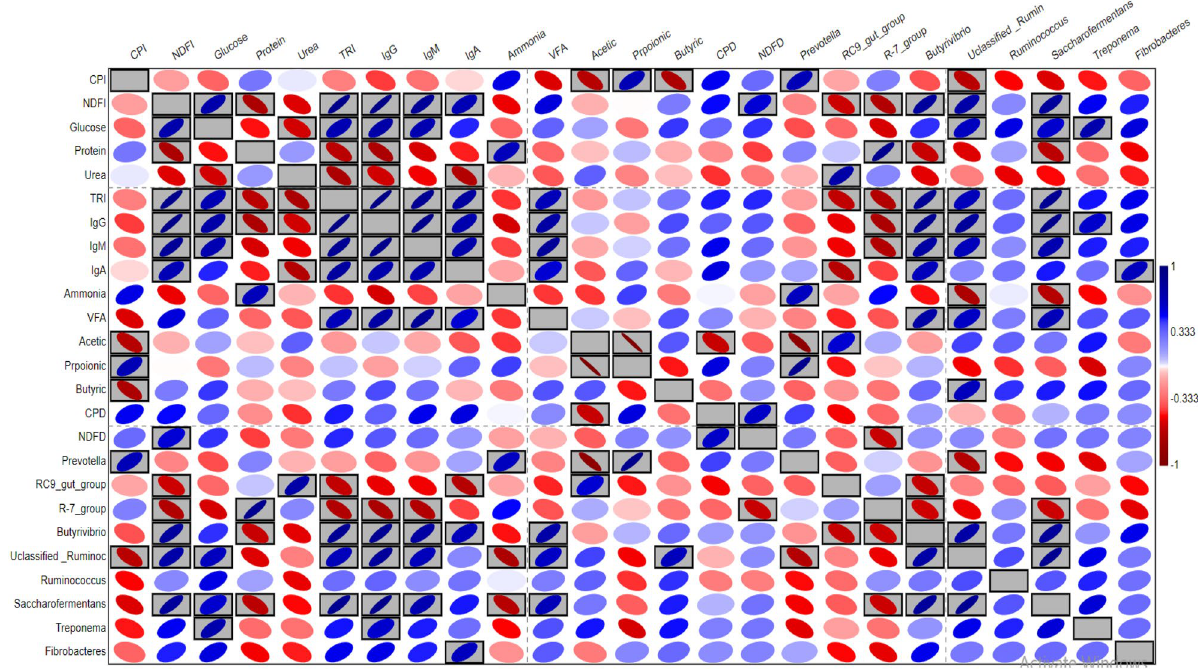
Figure 3. Heatmap based on Pearson correlation analysis. The heatmap shows the correlation relationships between feed intake (NDFI, CPI), blood biochemical and immunological parameters, rumen fermentation parameters, rumen disappearance of CP and NDF, and relative abundances of dominant bacterial genera in the rumen of camels and sheep under investigation. The black boxed ellipses refer to the significant